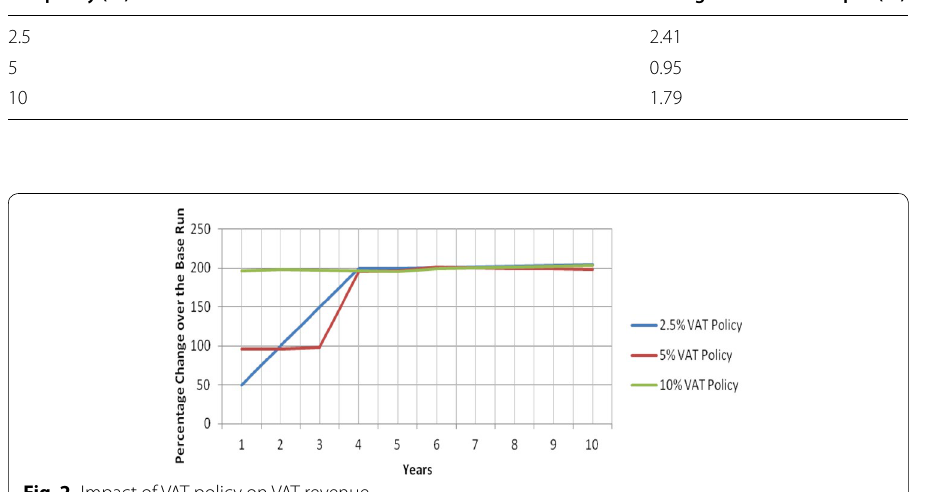
Fig. 2 Impact of VAT policy on VAT